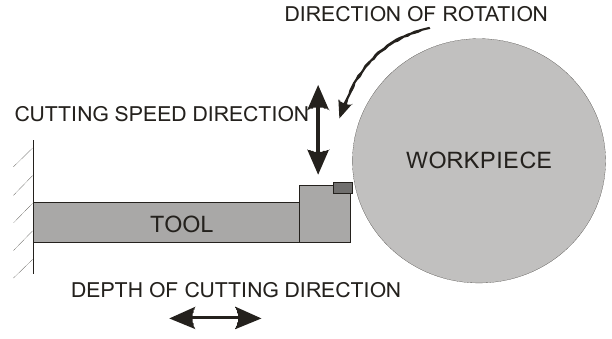
Figure 2. Graphical model of machining by turning.